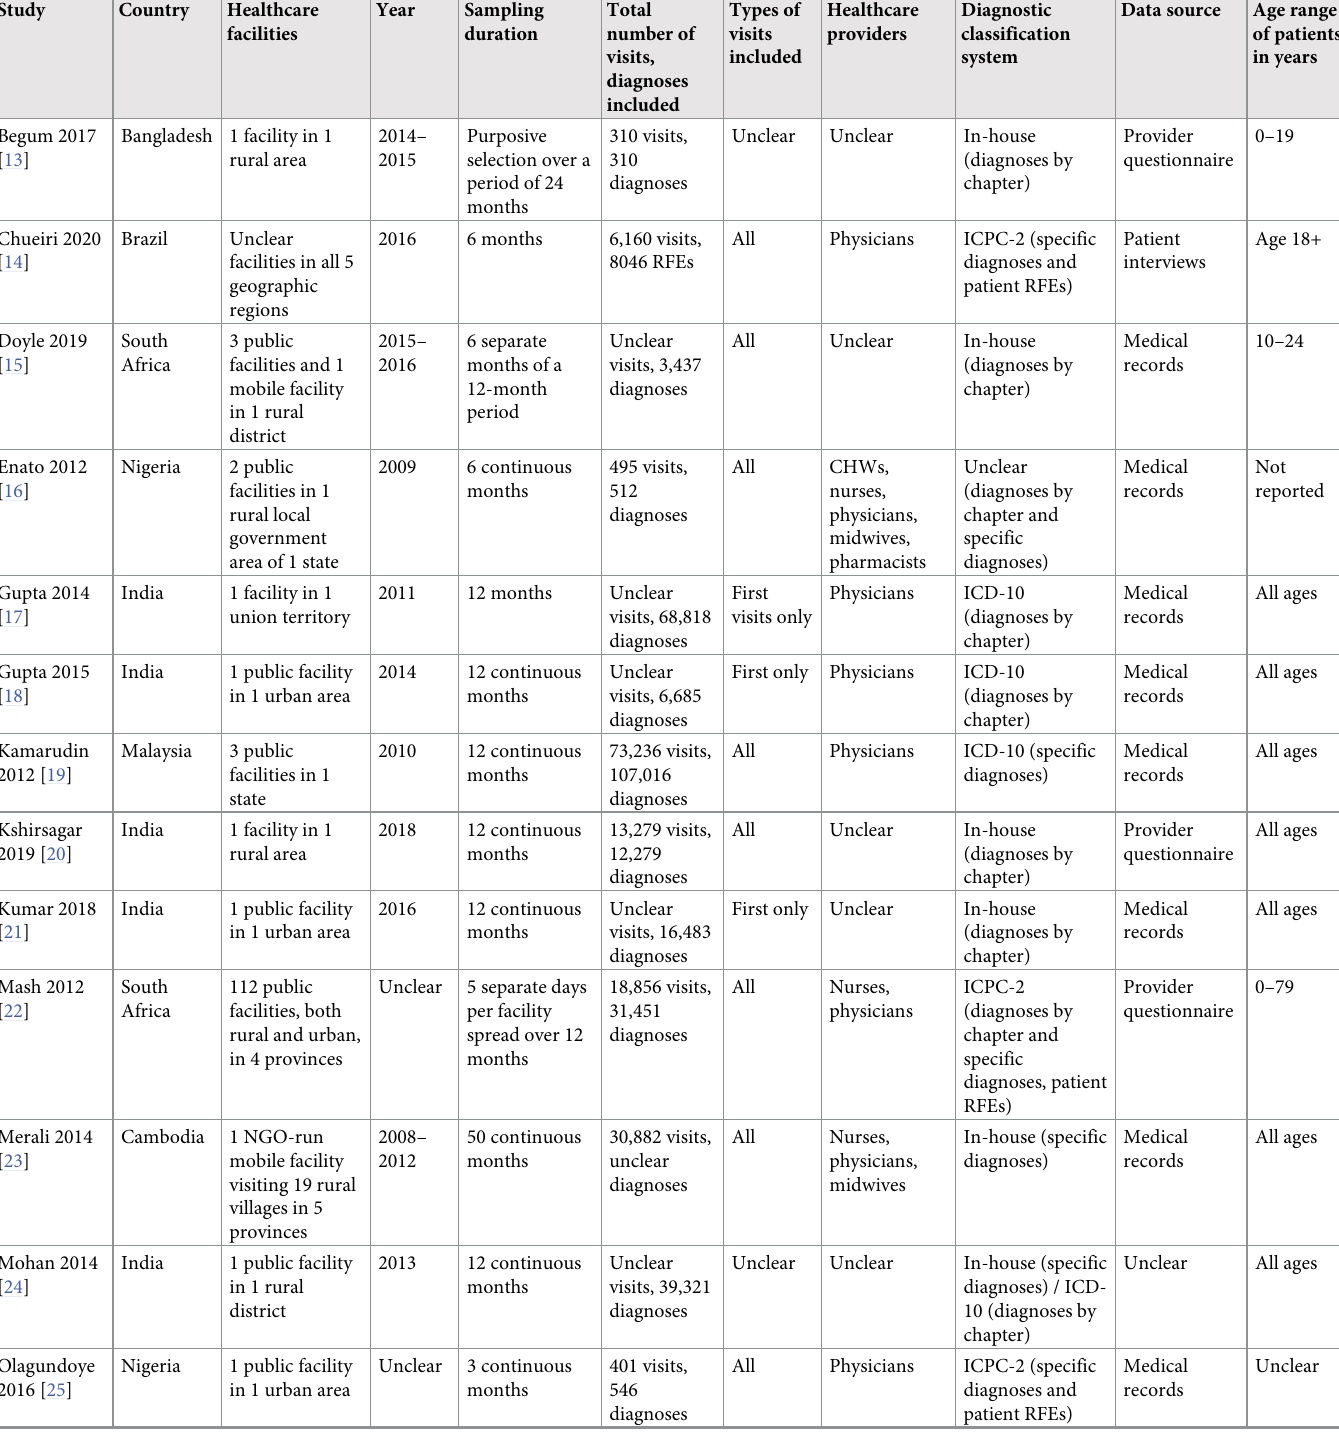
Table 1. Characteristics of included